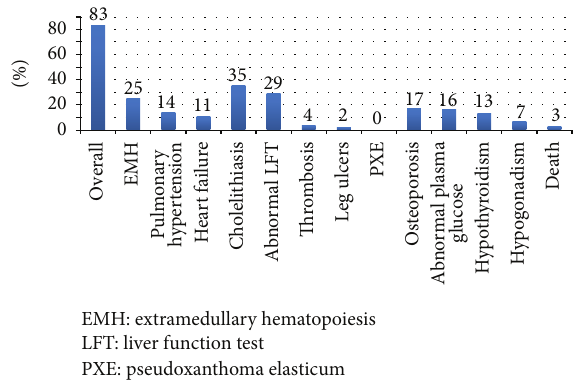
Figure 1: Percentage of complications and mortality in study